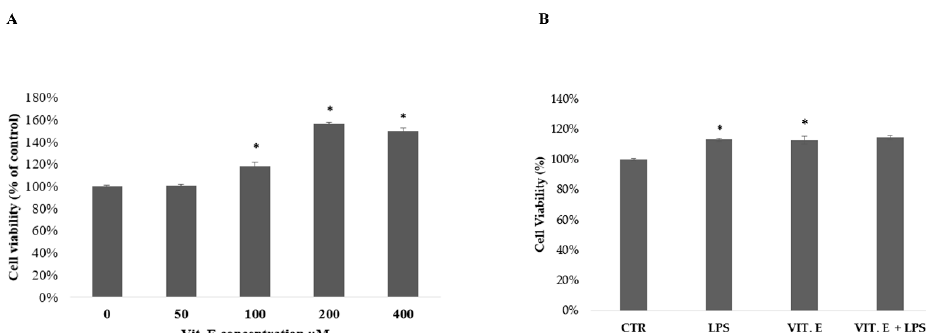
Figure 1. Cell viability analysis of vitamin E using an MTT assay. BV2 cells were treated with a vitamin E dose–response curve from 50 µ M to 400 µ M ( A ). Vitamin E at a concentration of 100 µ M was used to treat cells in the absence or presence of 1 µ g/mL LPS ( B ). Data are reported as percentages compared to control values and are expressed as means ± SDs. * p < 0.05 compared to the control of the same time point.